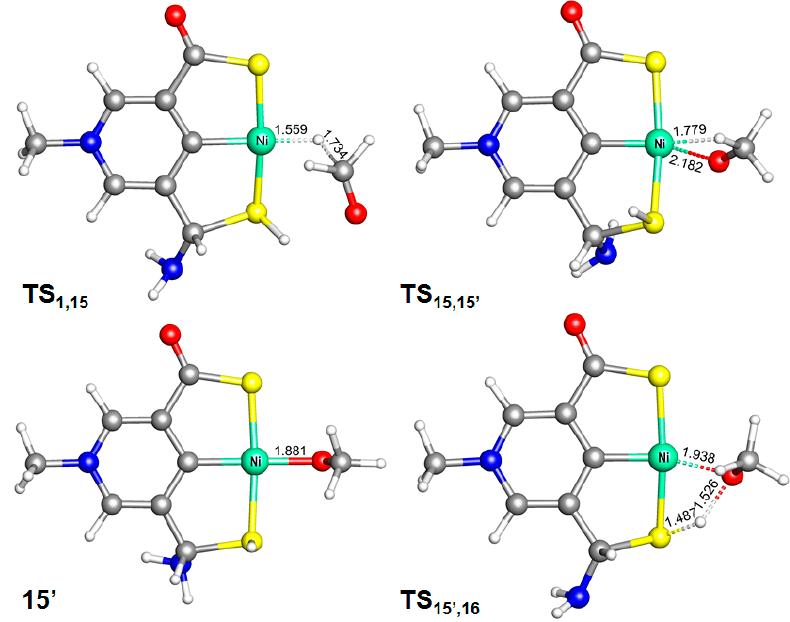
Figure 8. Optimized structures of 15’ , TS 1,15 (532.2 i cm − 1 ), TS 15,15’ (191.8 i cm − 1 ), and TS 15’,16 (1347.0 i cm − 1 ). Bond lengths are in Å.